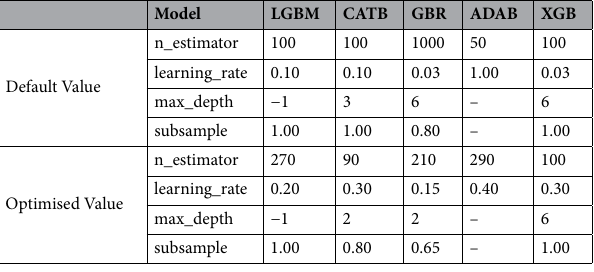
Table 4. Summary of hyperparameter tuned values.